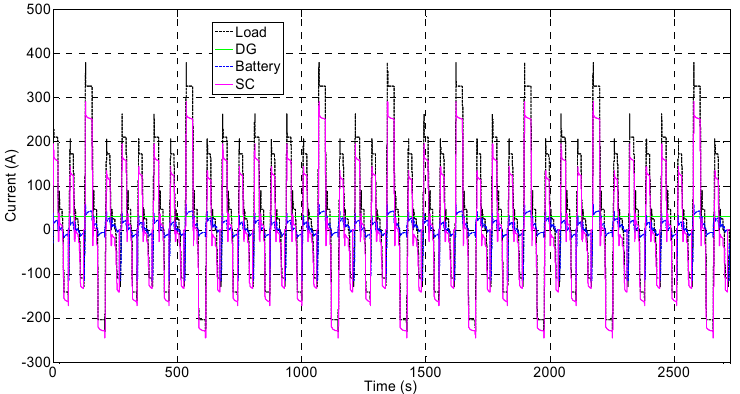
Figure 12. Output currents of the three devices under continuous work